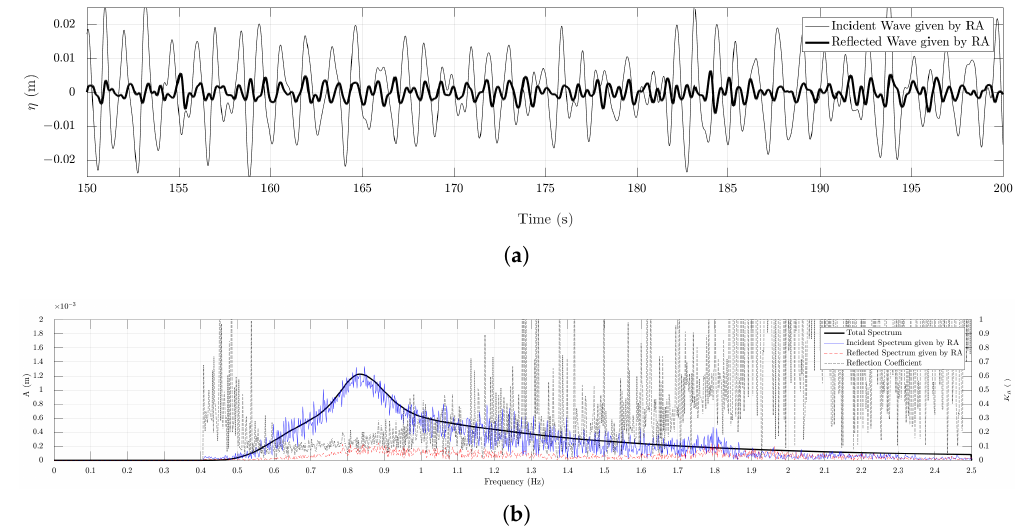
Figure 4. Surface elevation and the wave spectrum using the JONSWAP spectrum for wave generation with H s = 0.04 m and T p = 1.2 s using DM-AWA. ( a ) Time series of incident (regular line) and reflected (bold line) irregular wave; ( b ) wave amplitude components, total in bold, incident spectrum using reflection analysis in regular, reflected spectrum using reflection analysis in dashed and the reflection coefficient in dotted line.